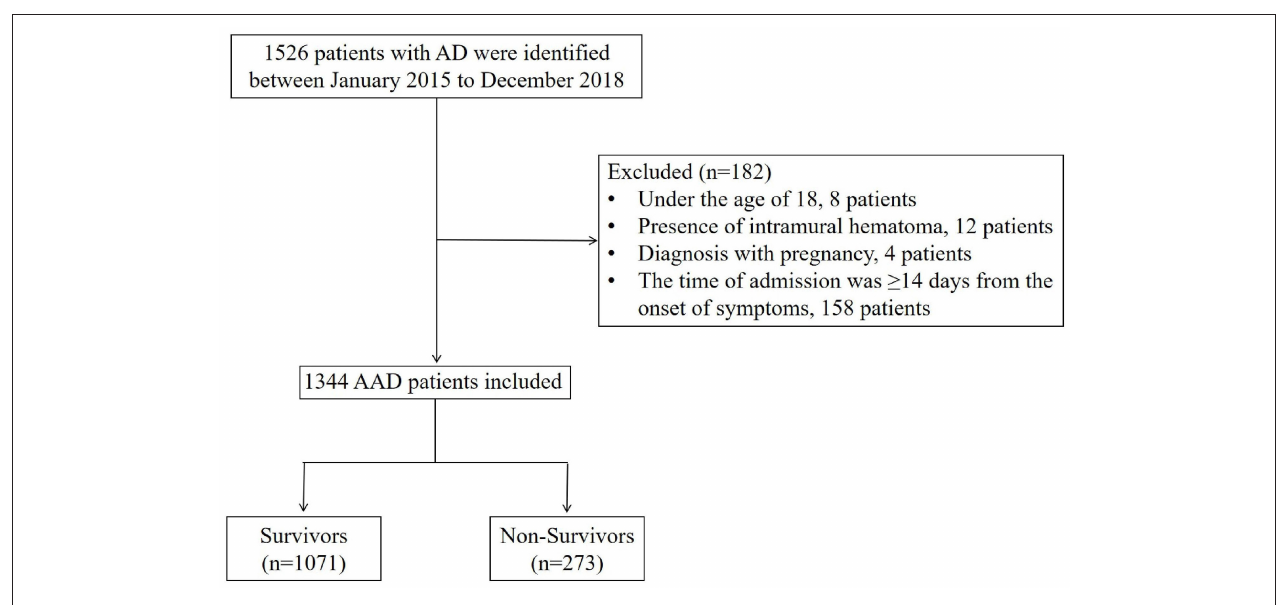
FIGURE 2 | Flow chart of patient